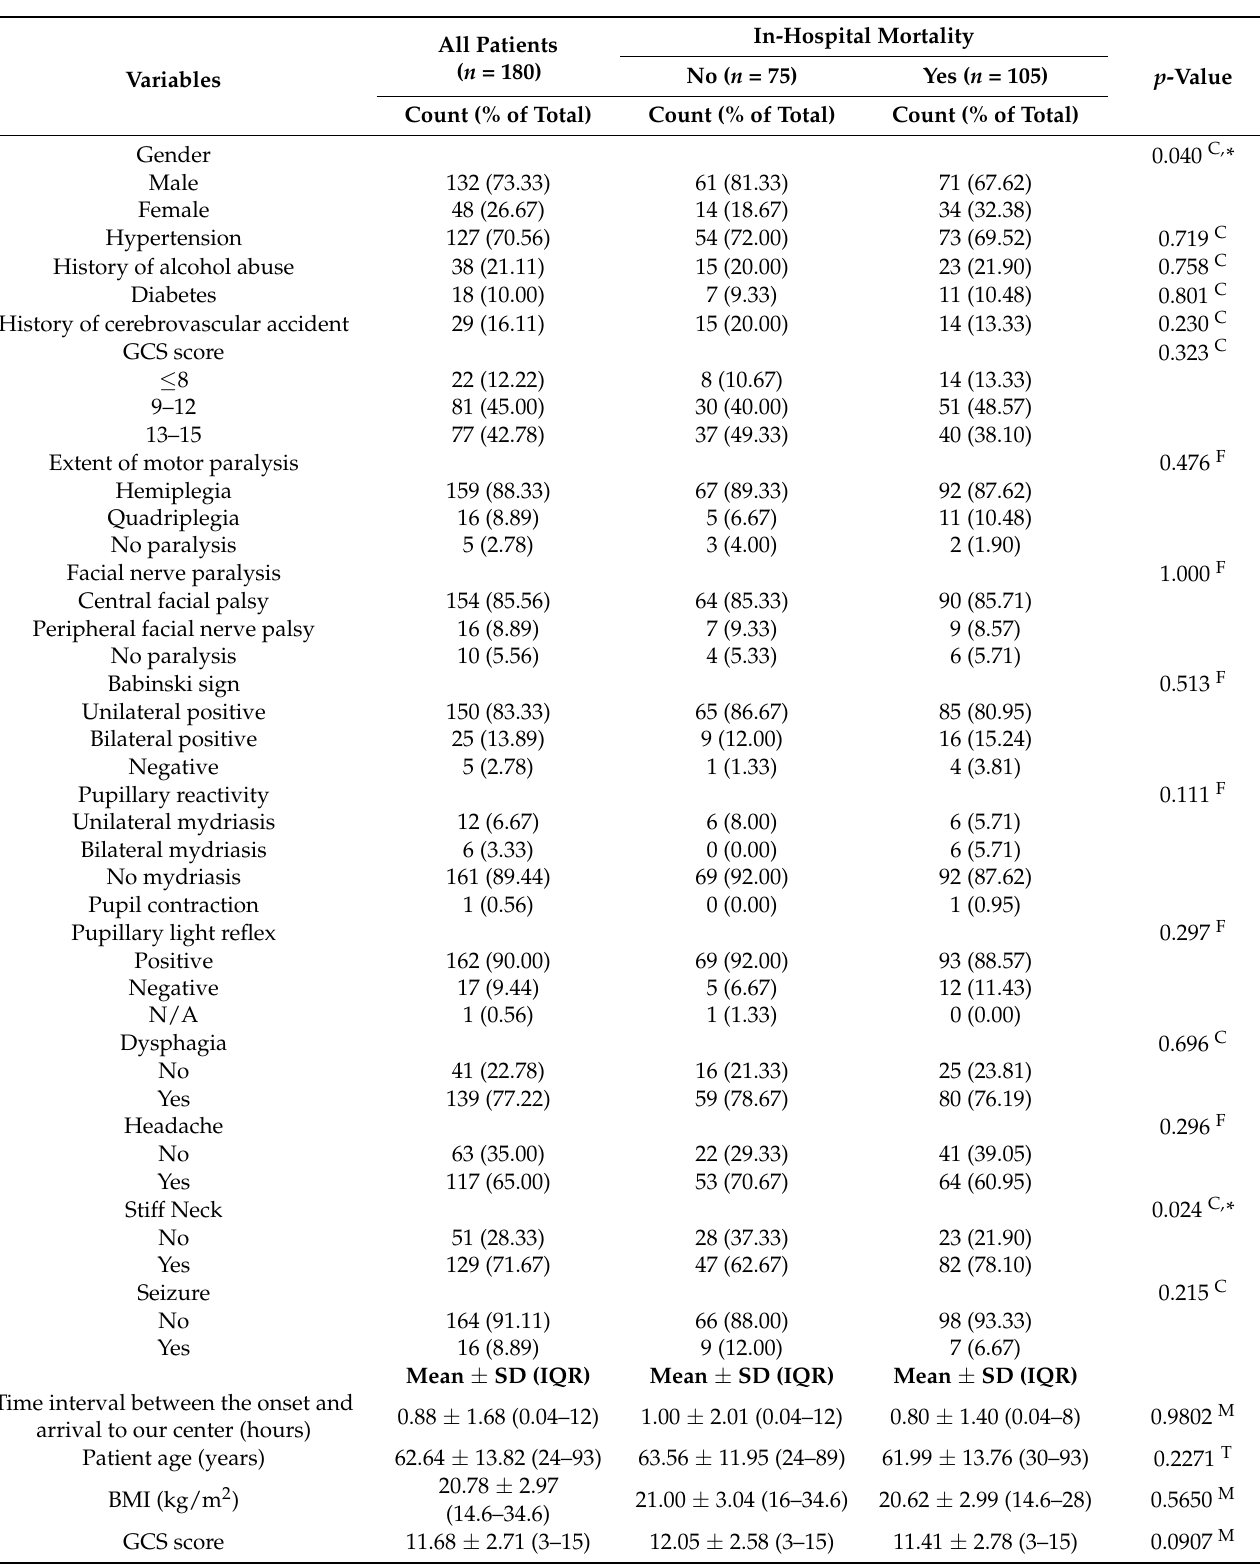
Table 1. Clinical data at admission for the in-hospital survival and in-hospital mortality patients with ICH.